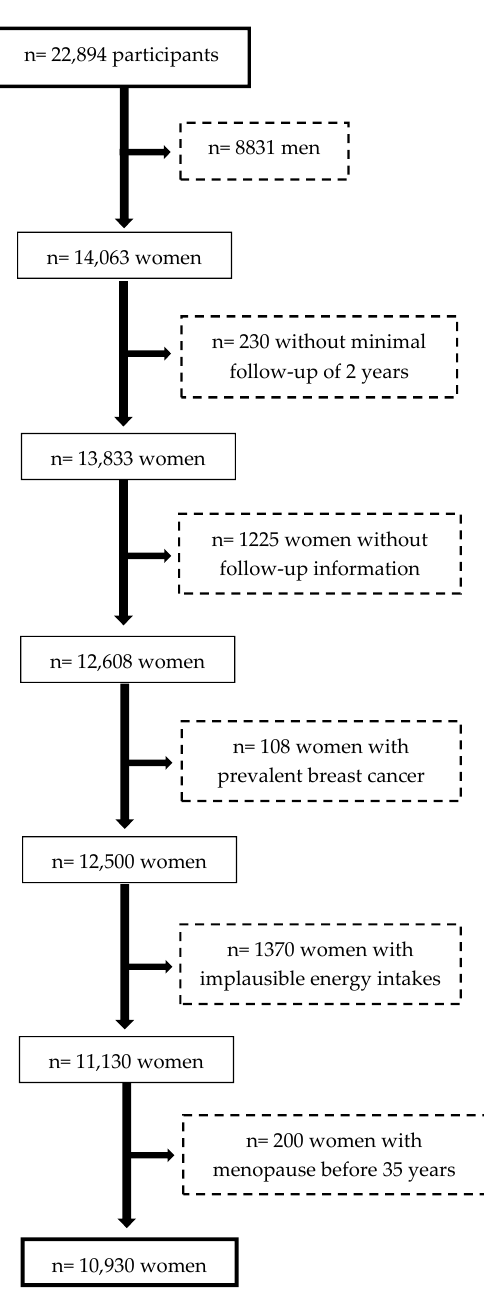
Figure 1. Flow-chart of participants in the SUN (“Seguimiento Universidad de Navarra”) Figure 1 . Flow-chart of participants in the SUN (“Seguimiento Universidad de Navarra”) Project.